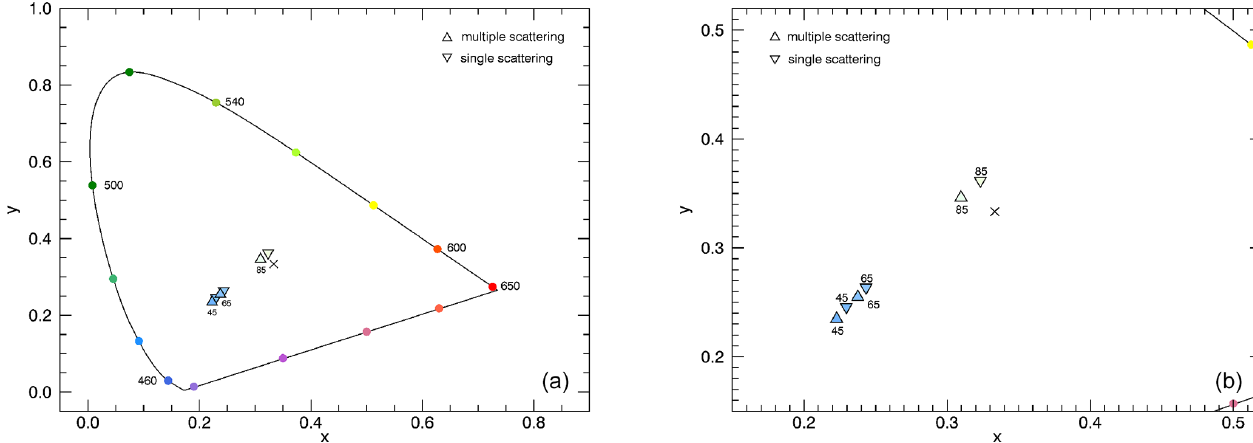
Figure 14. CIE chromaticity diagram for simulations with NLCs considering multiple scattering and single scattering only. Marked at the data points are the following: VZAs = 45, 65 and 85 ◦ , with SZA = 98 ◦ and SAA = 0 ◦ . The NLC parameters are the following: r m = 50nm, S = 1 . 4, τ NLC = 10 − 4 and z NLC = 82km. Panel (b) shows an enlarged version.